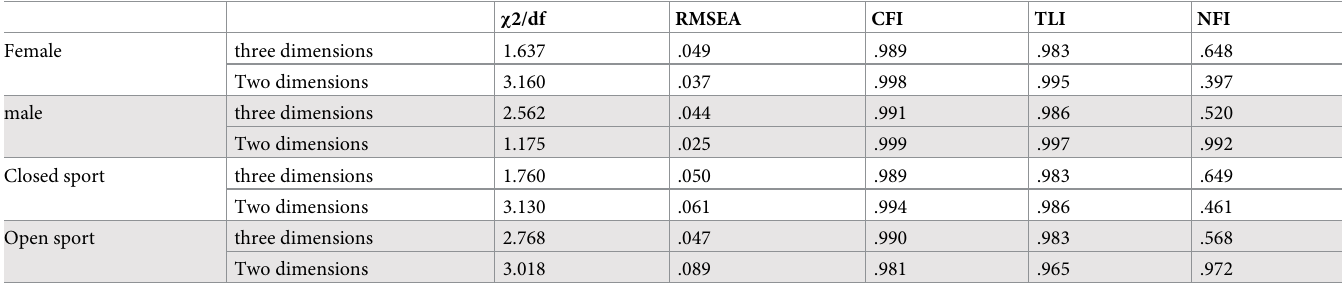
Table 2–3. Model structure fitting under different